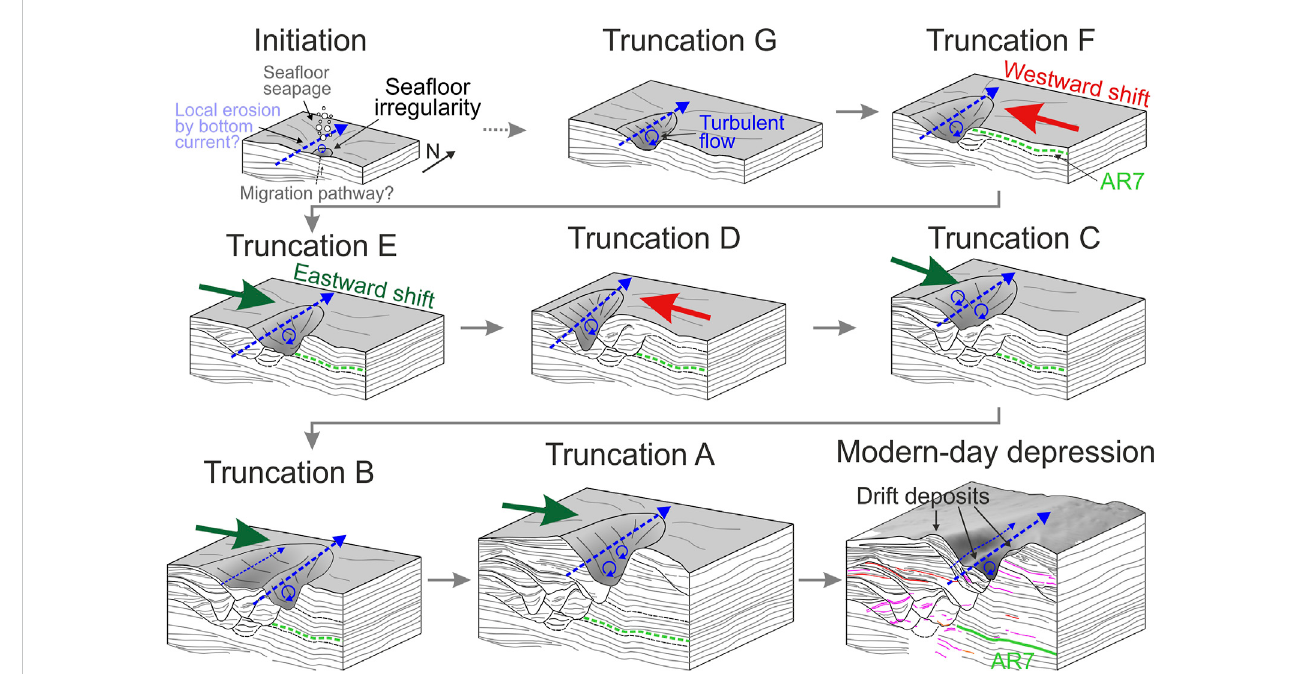
FIGURE 12 Conceptual model showing the development of SD-S over time (truncations G to A). Sea fl oor irregularities likely caused by sea fl oor seepage (Section 5.4.1) were enlarged by unidirectional bottom currents. Alternating erosion by strong bottom currents and deposition resulted in successions of cut-and- fi ll structures that exhibit a primarily eastward (downslope) and slightly northward shift of the depression structure. Colors for line drawing (current depression) from Figure 9. For a more detailed explanation, refer to the text (Section